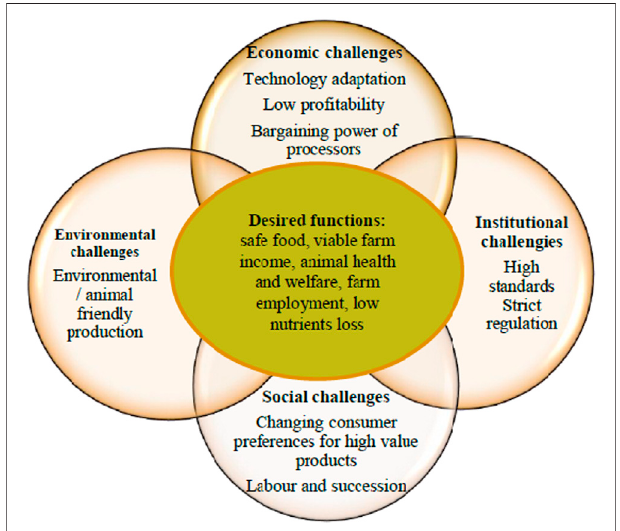
FIGURE 2 | Toward desired functions: main challenges identi fi ed for Swedish egg and broiler primary production.